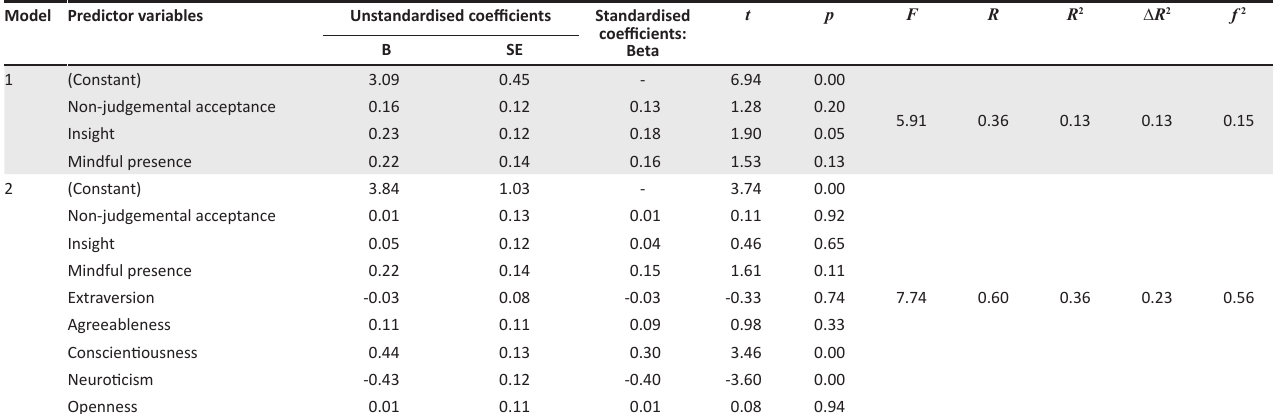
TABLE 5: Multiple regression analysis with manageability as a dependent variable. Model Predictor